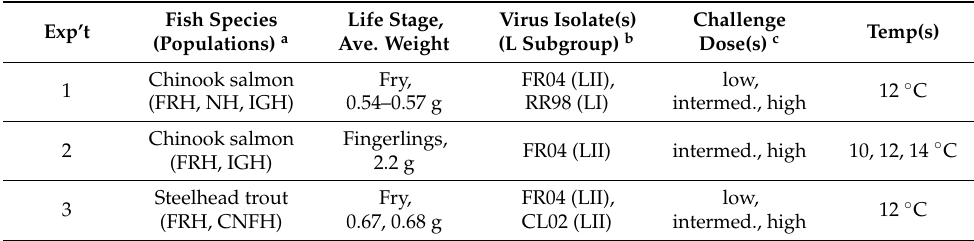
Table 3. Design of experimental studies of Chinook salmon or steelhead trout susceptibility to mortality after exposure to L genogroup IHNV isolates under various